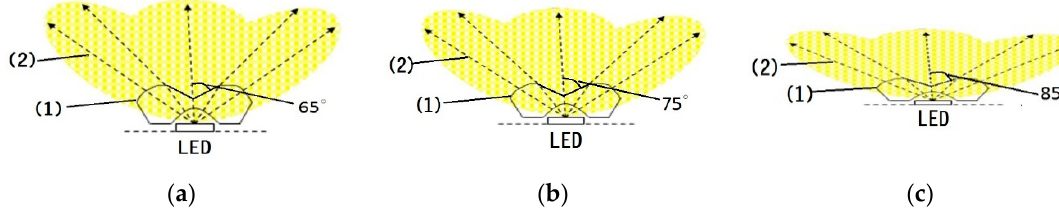
Figure 1. Schematic diagram of the target of secondary freeform lens (SFL) in light-emitting direction with lighting target angles of ( a ) 130°; ( b ) 150° and ( c ) 170°. (1) Refracting surface; (2) projection light passing through the SFL directly.